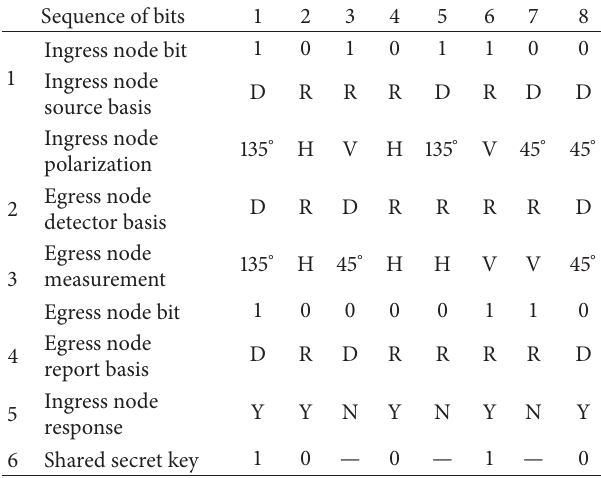
Table 3: An 8-bit sample of BB84